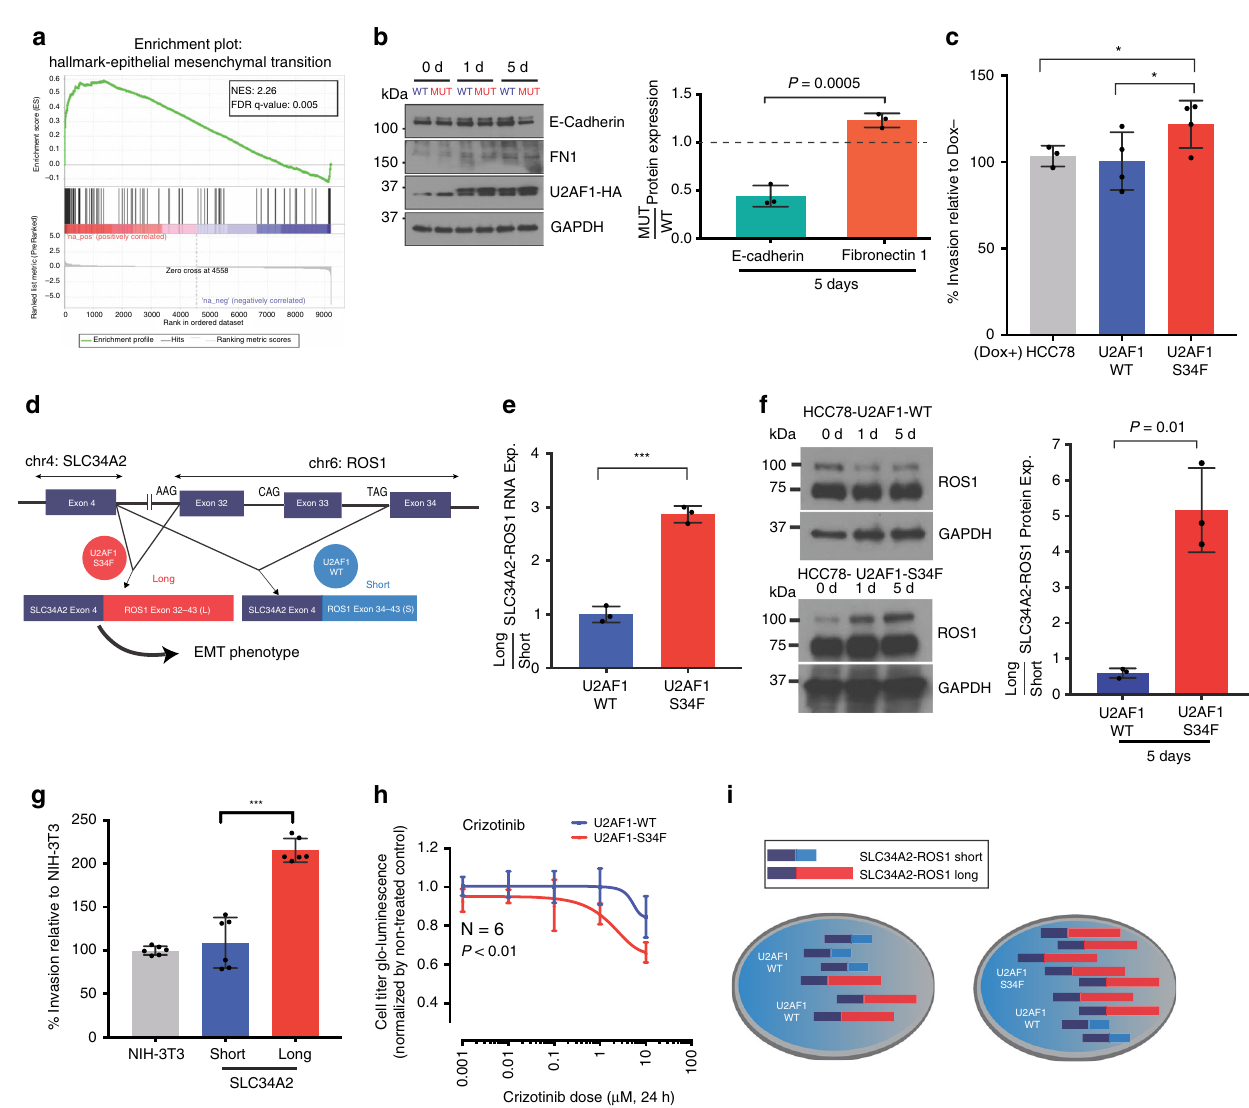
Fig. 5 Functional signi fi cance of U2AF1 S34F in relation to SLC34A2-ROS1 fusions. a Gene set enrichment analysis (GSEA) plot of differential expression data. The most enriched gene set is the hallmark epithelial mesenchymal transition. b Relative protein expression of E-cadherin and fi bronectin 1 (FN1) in HCC78 cells. Experiments were performed in triplicate. c Overexpression of U2AF1 S34F mutant increases invasion potential in HCC78. Wild-type and mutant U2AF1 were overexpressed in a doxycycline-inducible manner and plated for 48 h. d Schematic of SLC34A2-ROS1 splicing in HCC78. Exon 4 of SLC34A2 is fused to exon 32 or exon 34 of ROS1, creating long and short isoforms, respectively. e Relative expression of long:short SLC34A2-ROS1 isoform ratios in mutant and wild-type U2AF1 overexpressed cell lines as measured by RT-qPCR using isoform speci fi c primers. The long and short isoforms in the mutant and wild-type overexpressed U2AF1 cell lines were normalized to the parental cell line, HCC78. f Relative protein expression of long to short SLC34A2-ROS1 isoforms in mutant and wild-type U2AF1 transduced cell lines as measured by Western blots, where HCC78 isogenic cells were exposed by 0.2 u µ g/ml of doxicycline for 0, 1 day and 5 day to induce the U2AF1 expression. The long and short isoforms in the mutant and wild-type transduced U2AF1 cell lines were normalized to the GAPDH, with densitometry data from 5d summarized in bar plot (right). The band intensity was measured by Image J software. g The long ROS1 isoform increases invasion potential in the NIH-3T3 cell line after 48 h. The short and long SLC34A2-ROS1 isoforms were transduced in NIH-3T3 fi broblasts using lentivirus. h Sensitivity of wild-type versus S34F mutant U2AF1 transduced HCC78 cells to the ROS1 inhibitor crizotinib. Experiments were done with 6 technical replicates where cells were exposed to the drug for 24 h and cell survival rate was measured